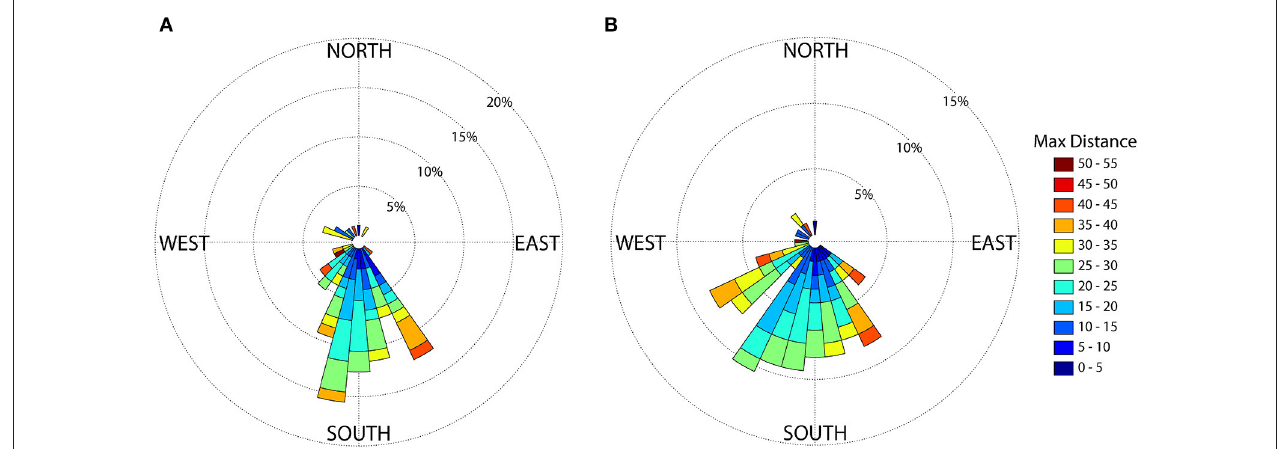
FIGURE 4 | Brown noddy headings (A) at the approximate time of departure (5km from the colony) and (B) from the colony to the maximum distance from the colony. The length of each 10 degree bin reflects the percentage of birds using that particular heading. Within each bin, colored subdivisions represent the maximum distance from the colony (in km) and the length of subdivisions represent the number of trips that fell into each subdivision of maximum distance from the colony.